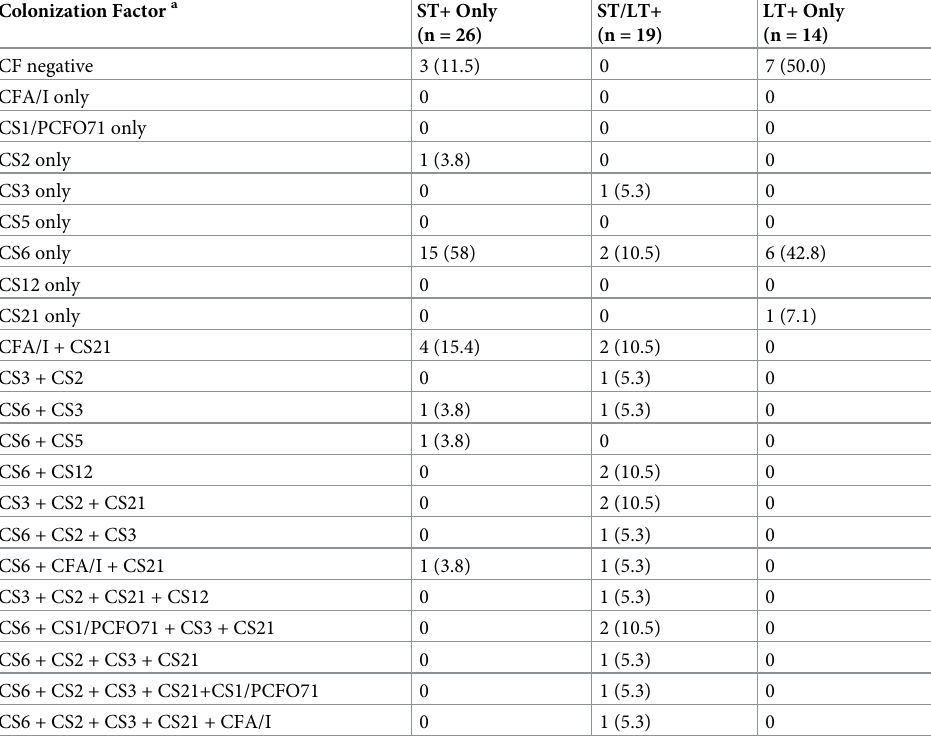
Table 1. Distribution of colonization factors among ETEC positive stool samples (n =